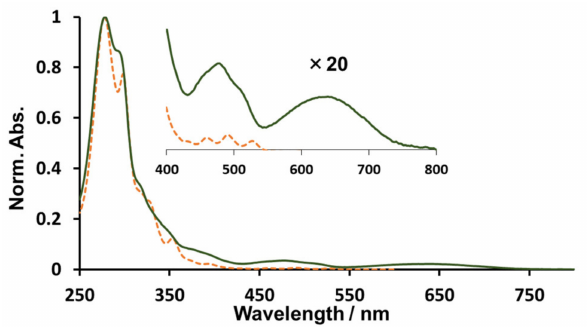
Figure 2. UV–VIS spectra of 1a (orange) and 2a (green) in CH 2 Cl 2 .